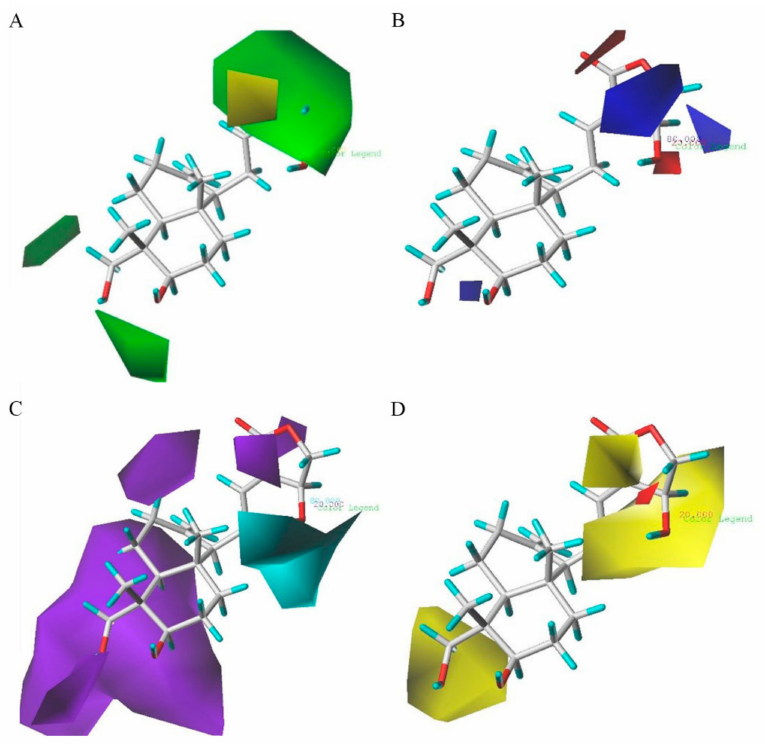
Figure8. CoMSIAStDev*Coeffcontourplotswiththecombinationofcompound AP-6 ingroup2. ( A )Steric field: Green and yellow contours refer to sterically favored and unfavored regions. ( B ) Electrostatic field: Blue and red contours refer to regions where electron-donating and electron-withdrawing groups are favored, respectively. ( C ) Hydrogen bond donor field: The cyan and purple contours indicate favorable and unfavorable hydrogen bond donor groups. The contour plots of the hydrophobic field are depicted in figure ( D ); Hydrophobic field: Yellow represents regions where hydrophobic groups increase activity; red represents regions where hydrophobic groups decrease